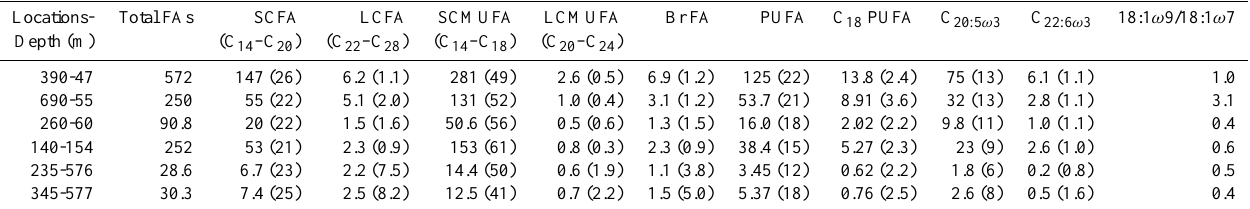
Table 10. Concentrations and diagnostic ratios of selected fatty acids (FAs) in sediments from the Beaufort Sea (µgg − 1 ). Percentage of total FAs is given in